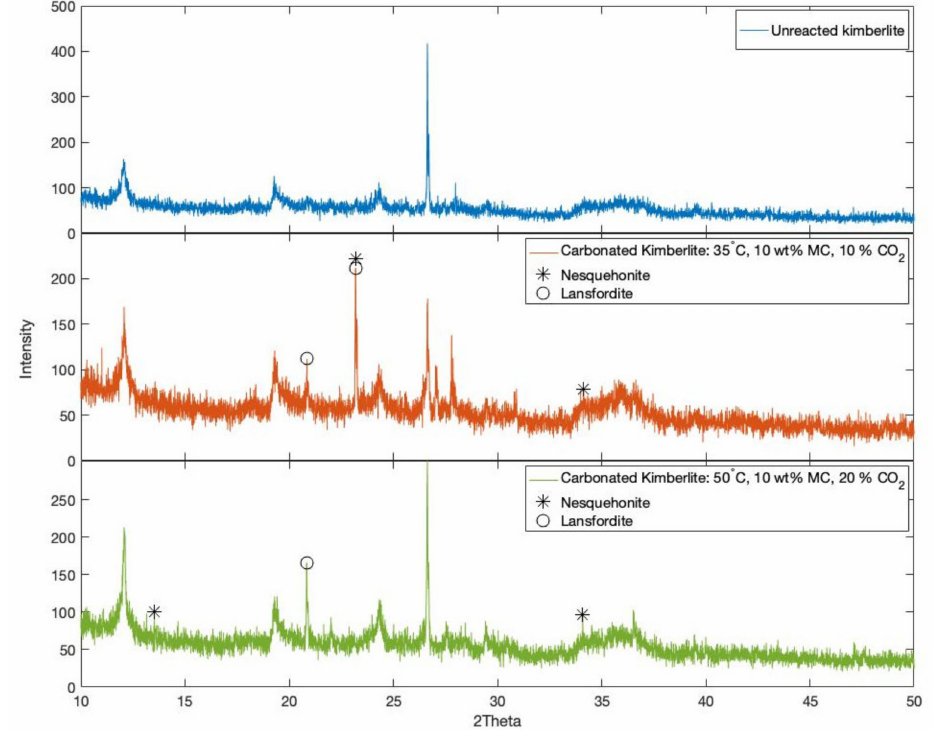
Figure5. ComparisonbetweentheXRDdi ff ractogramsofunreactedkimberliteandthin-filmcarbonated kimberlite at 35 ◦ C, 10 wt% moisture content, and 10% CO 2 concentration and at 50 ◦ C, 10 wt% moisture content, and 20% CO 2